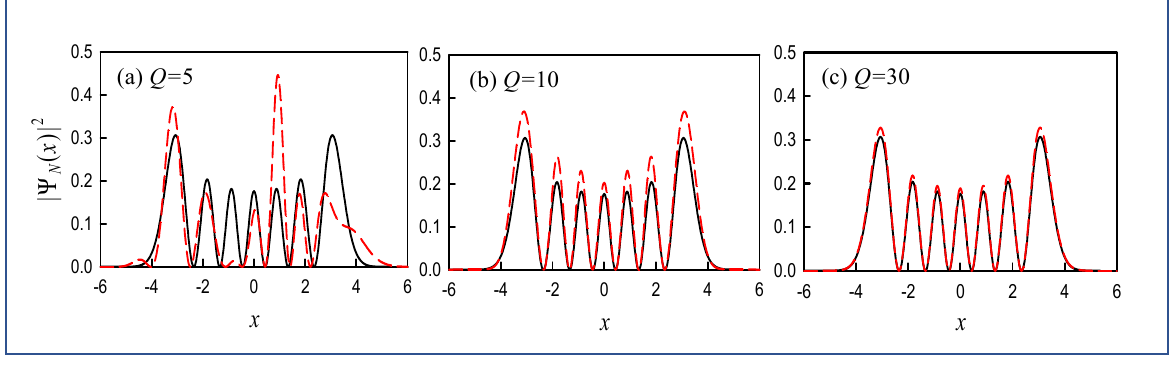
(cid:12) (cid:12) 2 | ( , ) | HG x y ψ   (solid lines) for three values of Q with P = 1 ( HG ) (cid:12) (cid:12) ( (cid:101) x , (cid:101) y ) (solid lines) for three values of Q with P = 1 0, N (cid:12) ψ (cid:12) 0, N